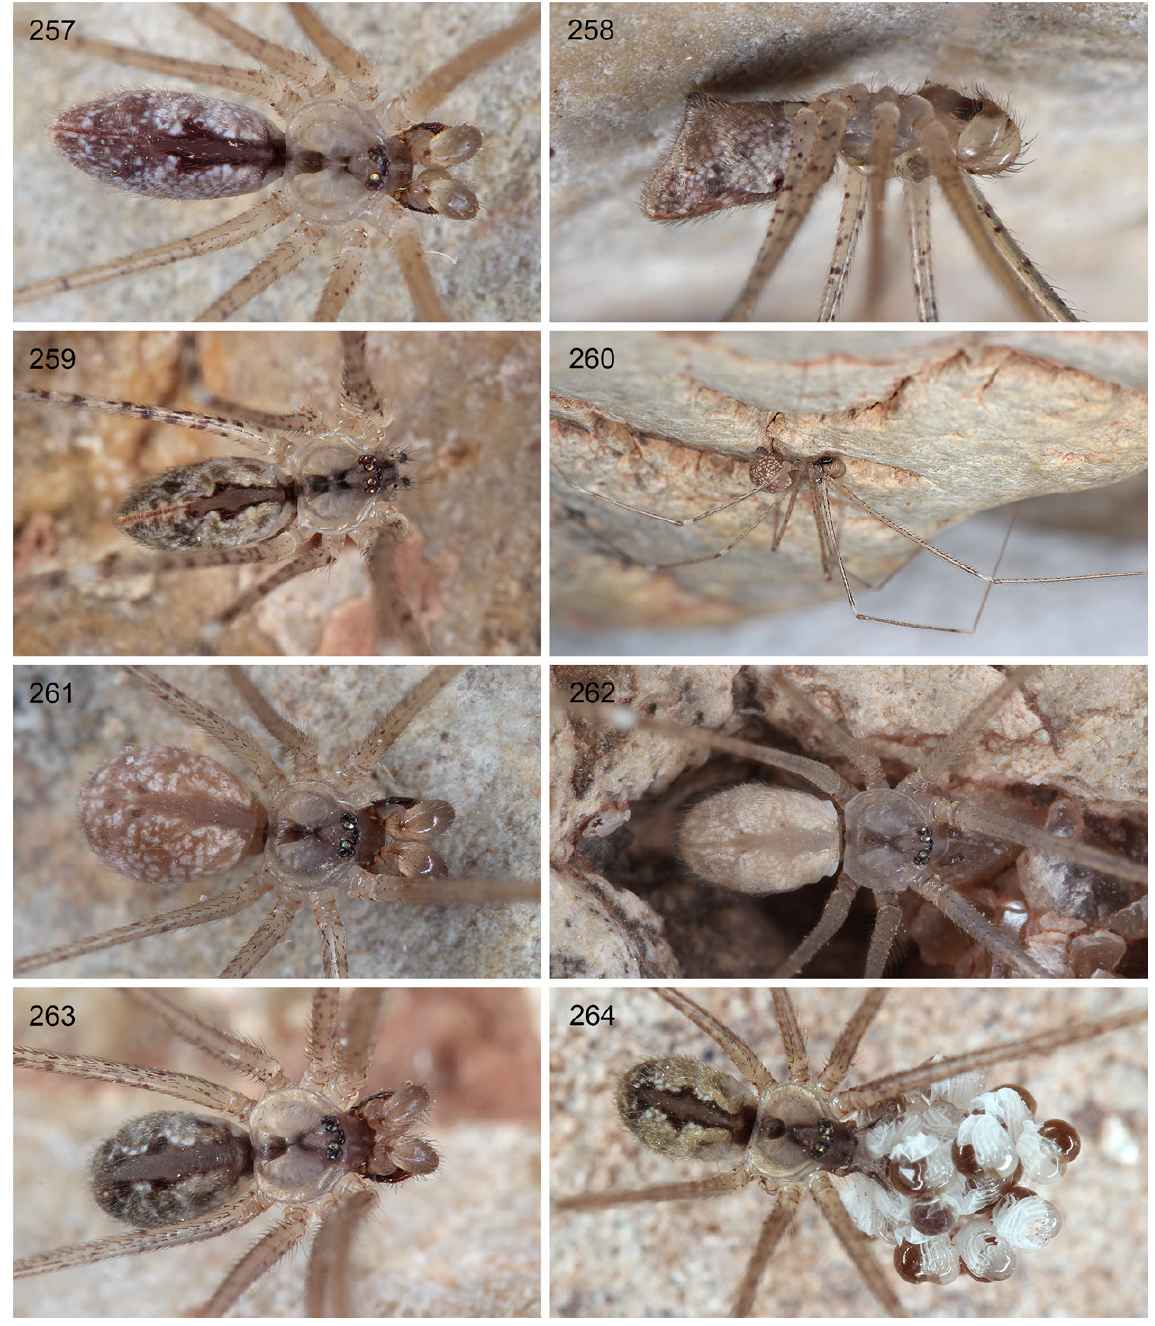
Figs 257–264. Maghreba gen. nov., live specimens. 257–259 . M. gharbija gen. et sp. nov., male and female from Morocco, E of Ghazoua. 260–262 . M. aurouxi (Barrientos, 2019) gen. nov., male and female from Morocco, SE of Zebzat. 263–264 . M. djabalija gen. et sp. nov., male and female with egg- sac from Morocco, NE of Tizi